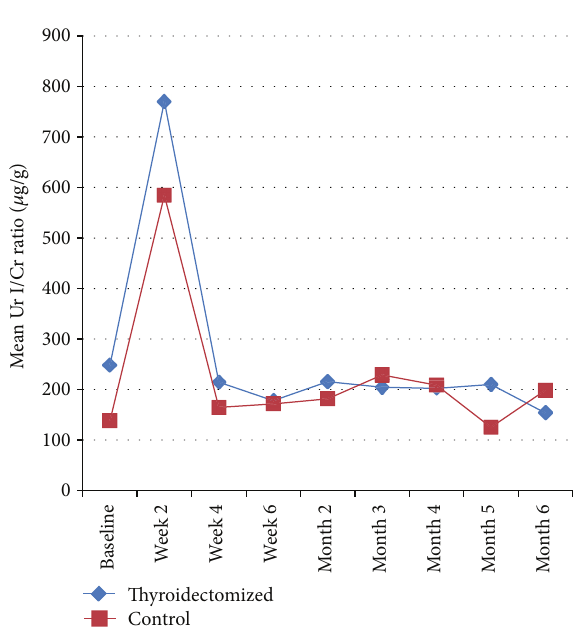
Figure 1: Mean urinary iodine creatinine ratios of thyroidectomised and control patients